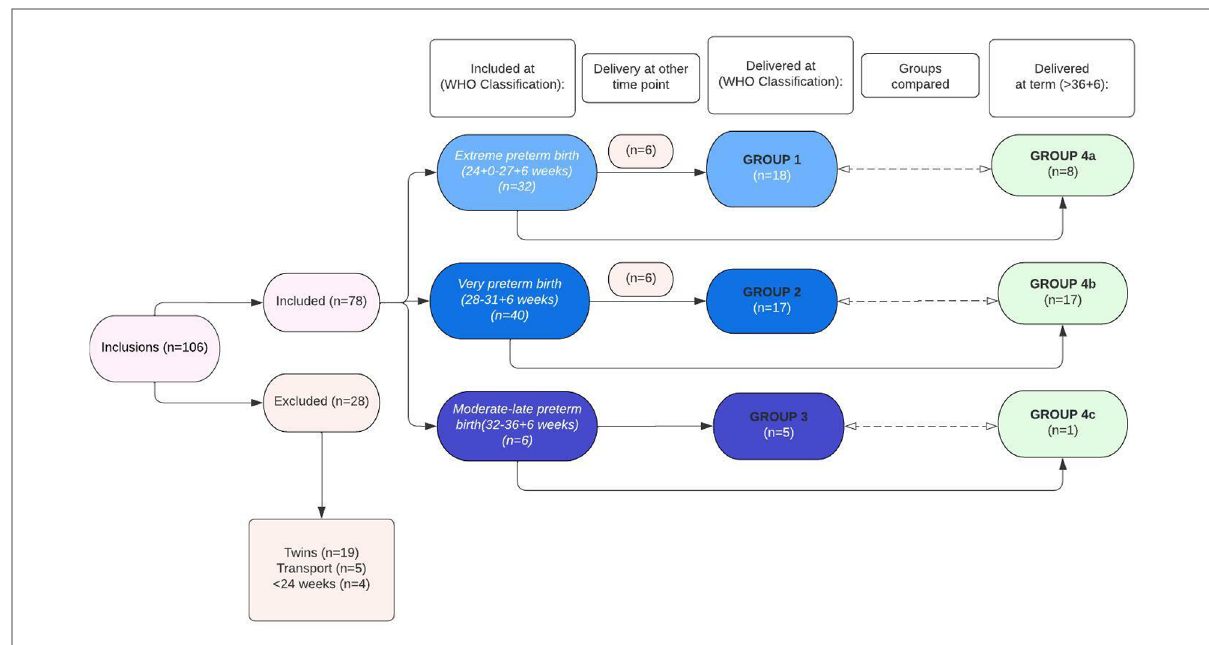
FIGURE 1 Flowchart showing inclusions and